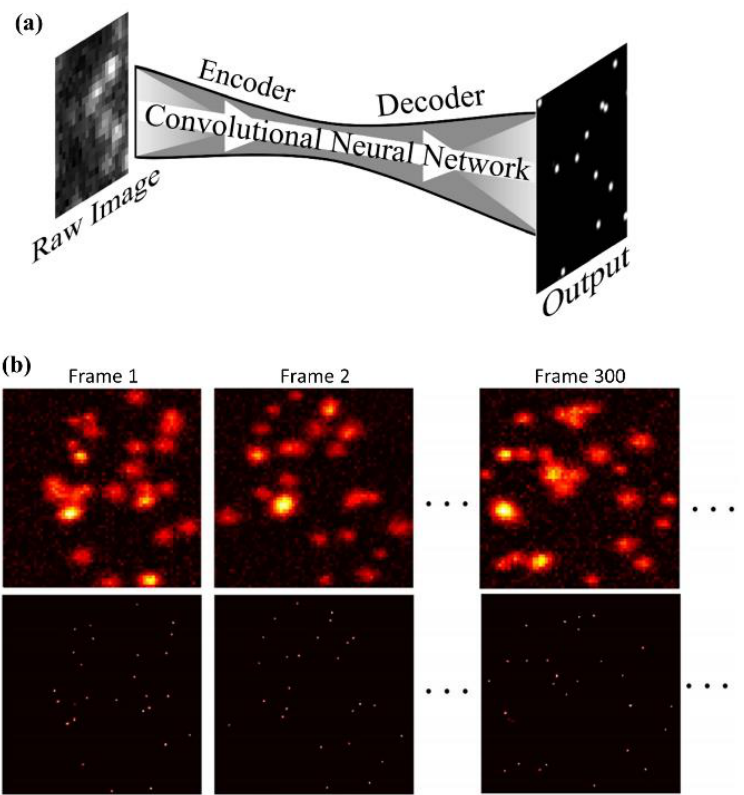
Figure 3. Super-resolution ultrasound localization microscopy through deep learning. ( a ) U-net based architecture for Deep-ULM [39], mSPCN-ULM [40], and a multiple-targets detecting net- work [47]. (Reprinted with permission from Ref. [47]. Copyright 2018 OSA) ( b ) An example of deep learning-based localization techniques—translation from the low-resolution image (top panel) to high-resolution frames (bottom panel) by the deep learning network [40,49]. (Reprinted with permission from Ref. [40]. Copyright 2020 IEEE).